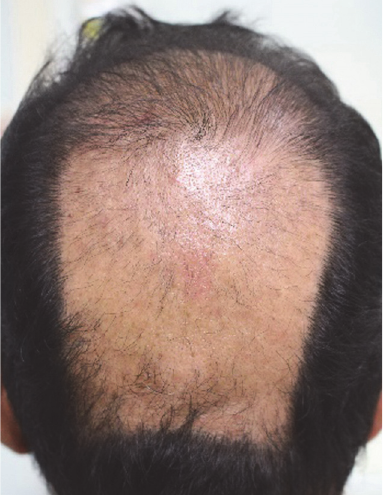
Figure 1: A sharply demarcated rectangular, nonscarring alopecia presented on the occipital scalp. Peak skin dose timeFluoro. time Rad